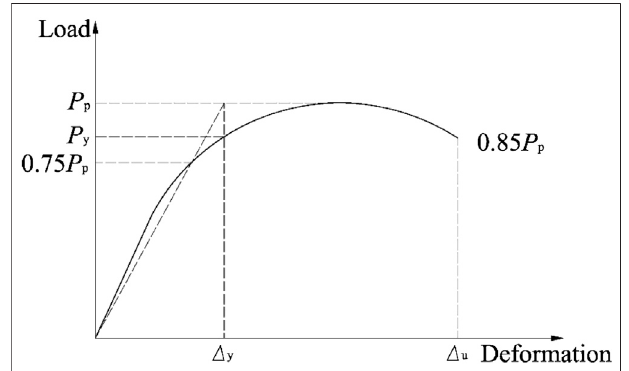
FIGURE 13 | Yield load and yield